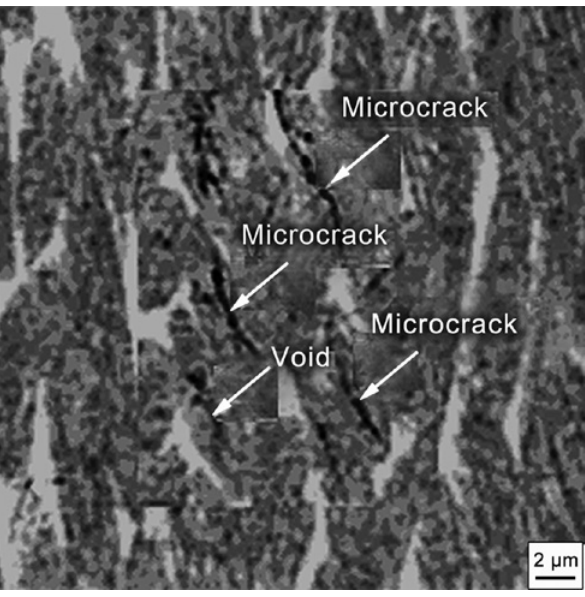
Figure 8: SEM micrograph of the interior of braided composites.